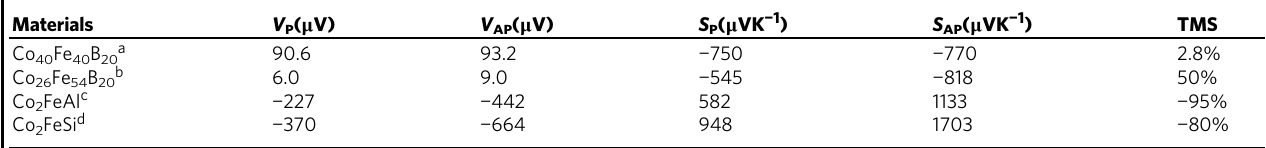
The elliptical MTJs have diameters of 2 μ m×1 μ m. The Seebeck voltages are obtained at 150mW laser heating a Co 40 Fe 40 B 20 /MgO 1.5nm/Co 40 Fe 40 B 20 , for more values see ref. 5